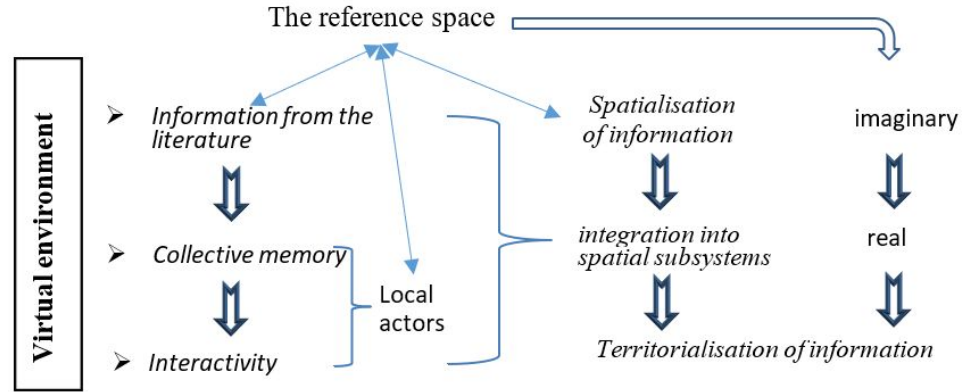
Figure 11. From the 3D virtual environment to the territorialisation of information.